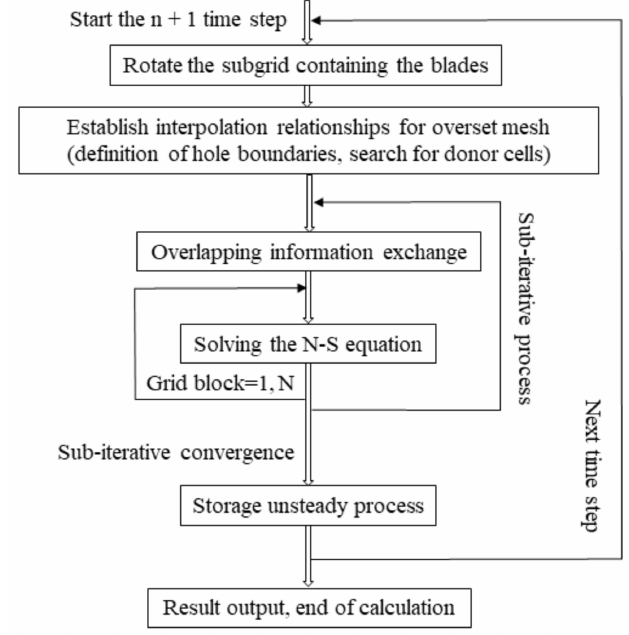
Figure 1. Flow diagram of the dual-time stepping method for overset